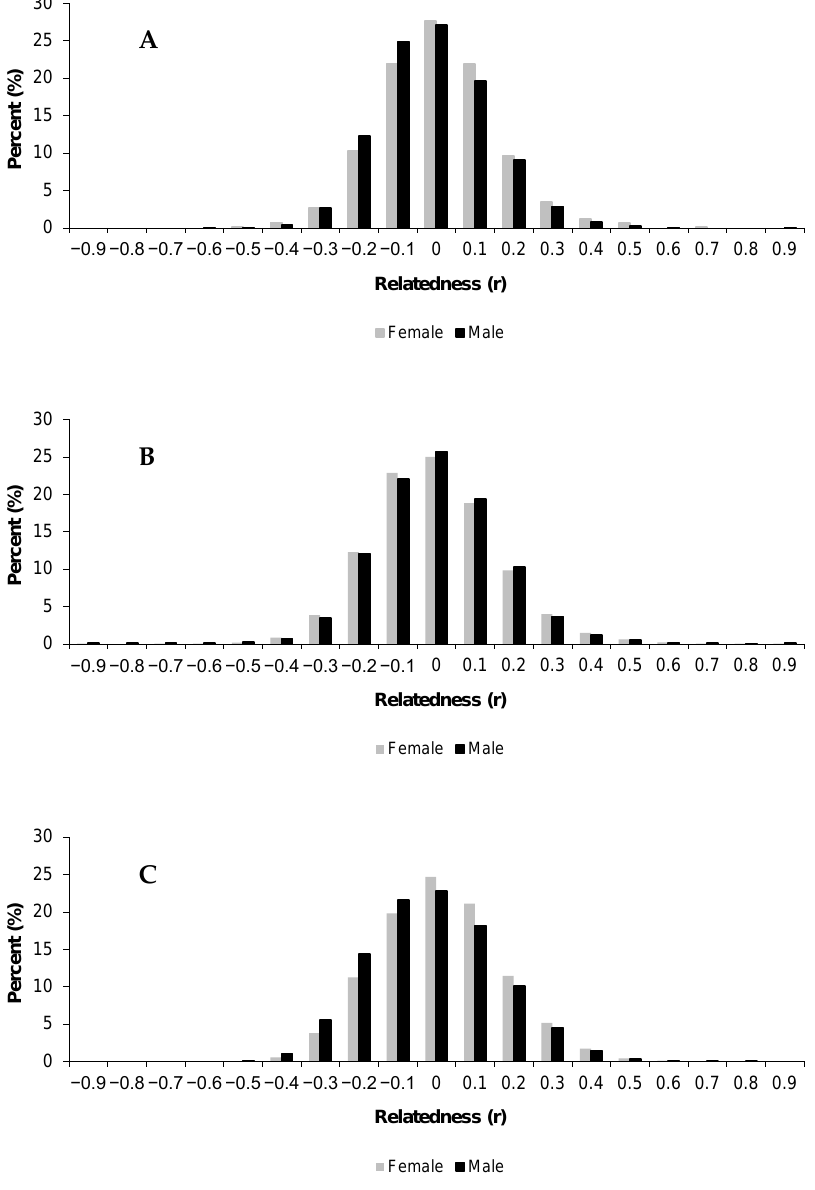
Figure 1. Distribution of pairwise relatedness ( r ) estimates of female and male white-tailed deer ( Odocoileus virginianus ) from Mississippi ( A ) 1999–2001, Oklahoma ( B ) 1991–2005 and Texas ( C )